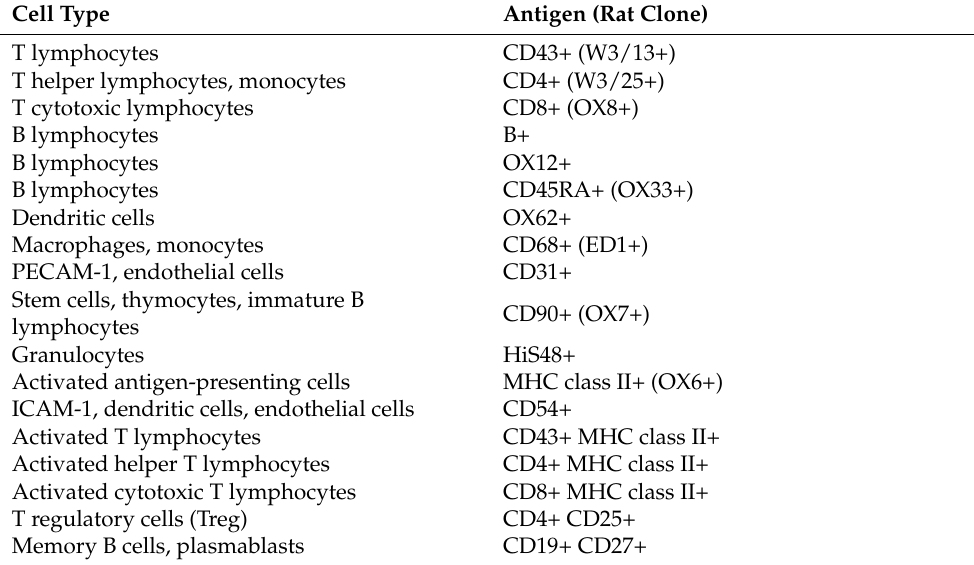
Table 1. Determination of cell phenotypes.